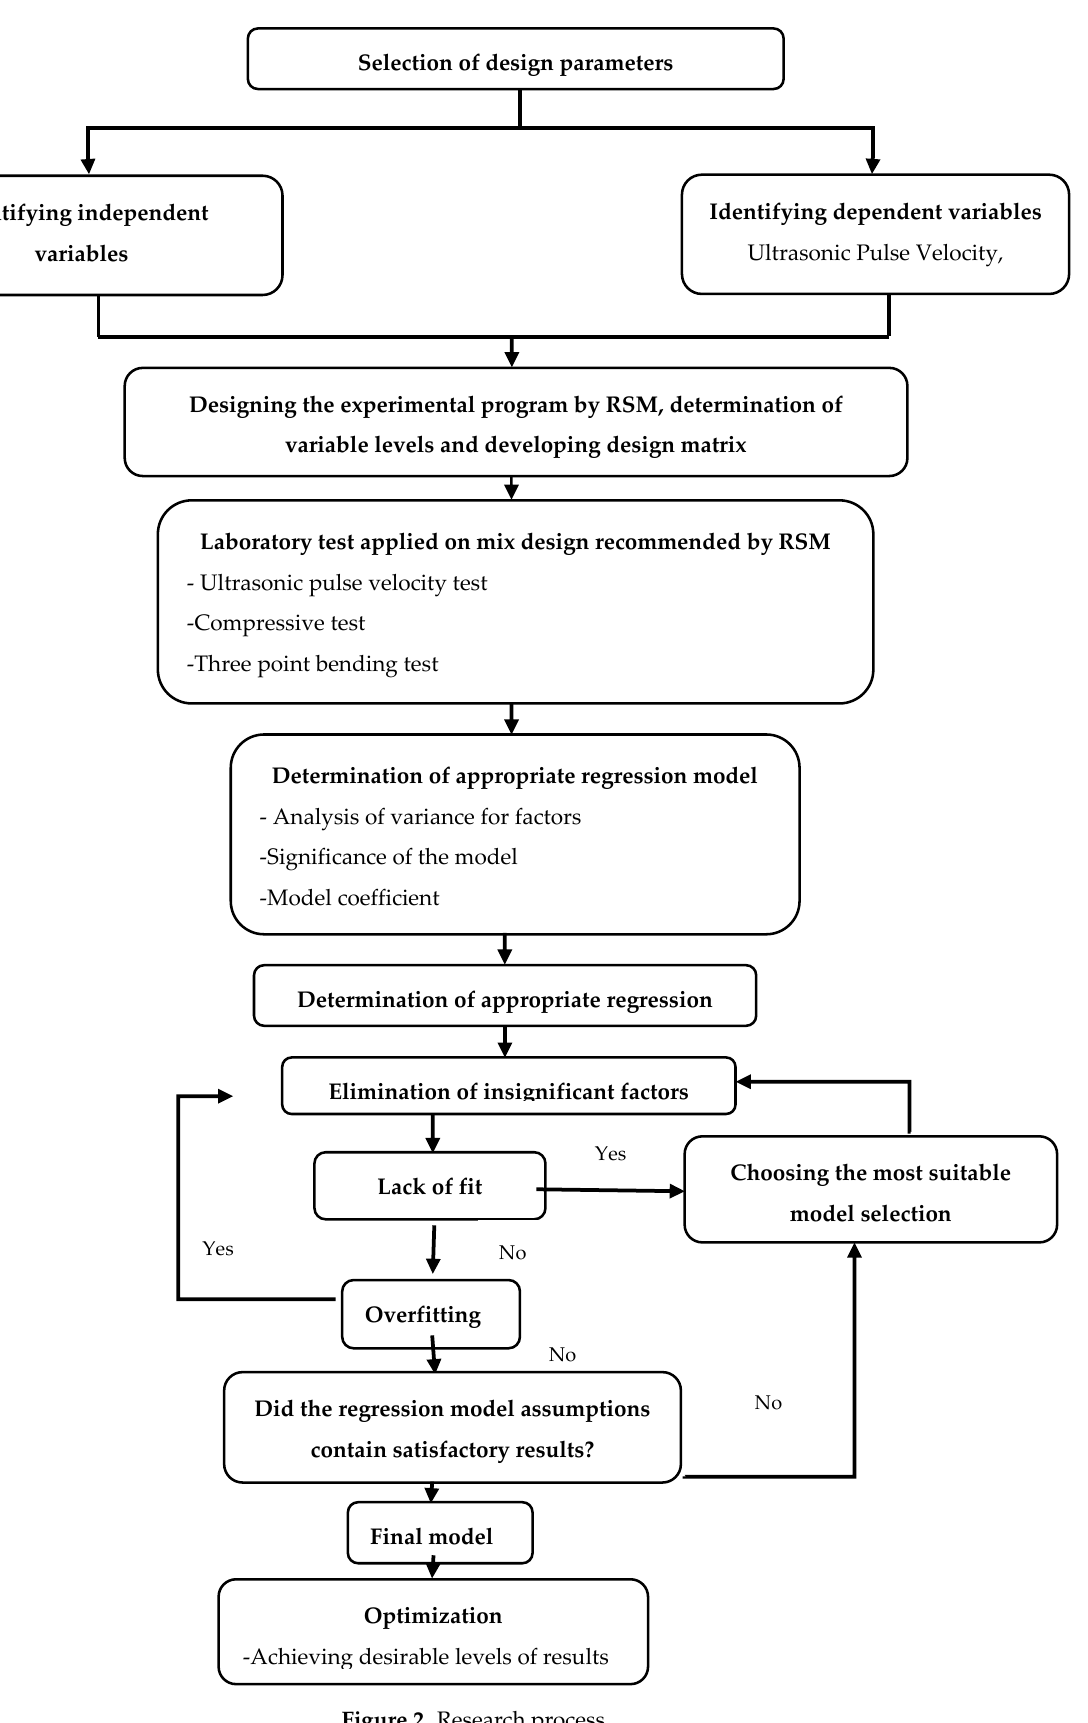
Figure 2. Research process.